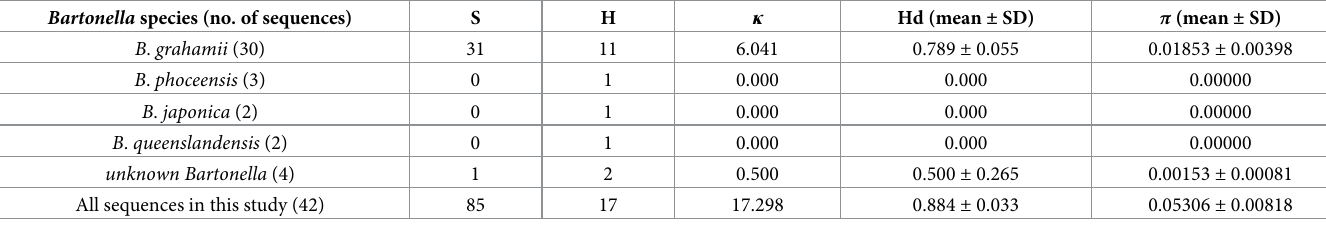
Table 4. DNA polymorphism of rodent-associated Bartonella species detected in Shangdang Basin. Bartonella species (no. of sequences)